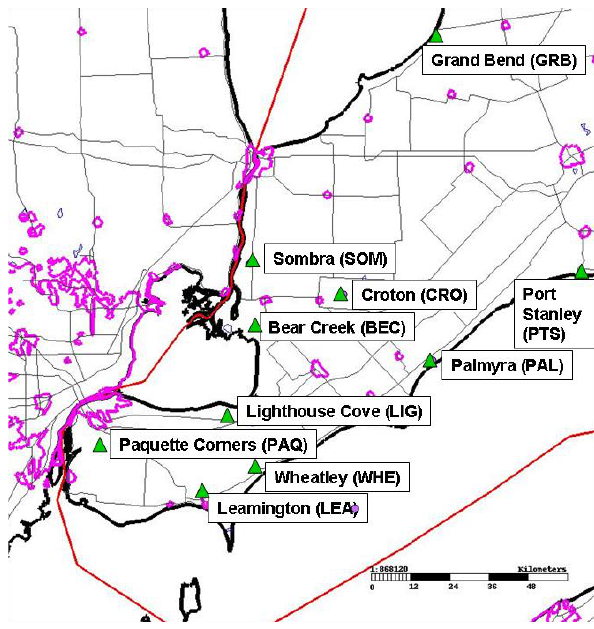
Fig. 8. Locations of BAQS-Met mesonet stations and the Harrow ozonesonde release